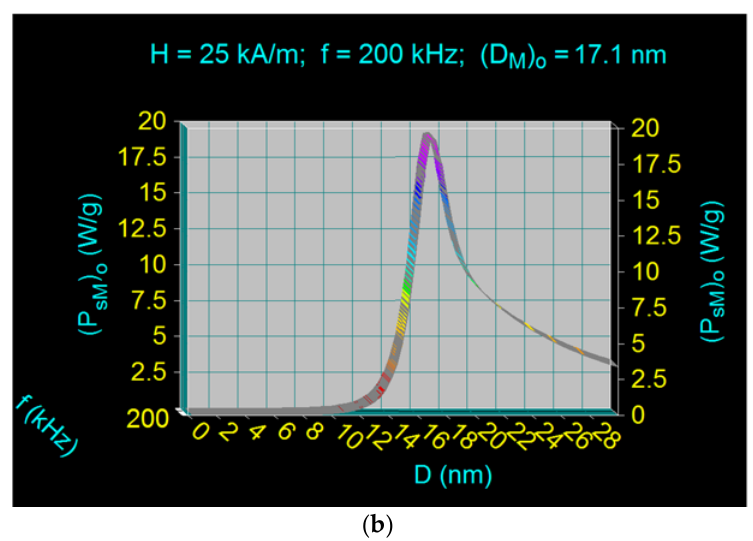
Figure 10. Maximum specific loss power for the allowable biological limit (P sM ) o at ( a ) 1000 kHz and ( b ) 200 kHz, for Fe 3 O 4 nanoparticles coated with γ -CDs dispersed in liquid. The results in Table 4 were obtained by calculating the maximum specific loss powers (P sM ) l for different limit frequencies (f l ) and the magnetic fields resulting from the condition given by Equation (10), using diagrams such as those of Figure 10. At the same time, for each maximum of the specific loss power, the corresponding values of the diameters of bionanoparticles were determined, called optimal diameters (D M ) o . The table also specifies the types of relaxations that take place at different frequency limits, mentioning comparatively the proportion of a relaxation process in relation to the other (Néel and/or Brown). Table 4. The values of maximum specific loss power (P sM ) l and optimal diameters D Mo for the allowable biological limit, in the case of Fe 3 O 4 nanoparticles coated with γ -CDs dispersed in liquid. Observables Nr.